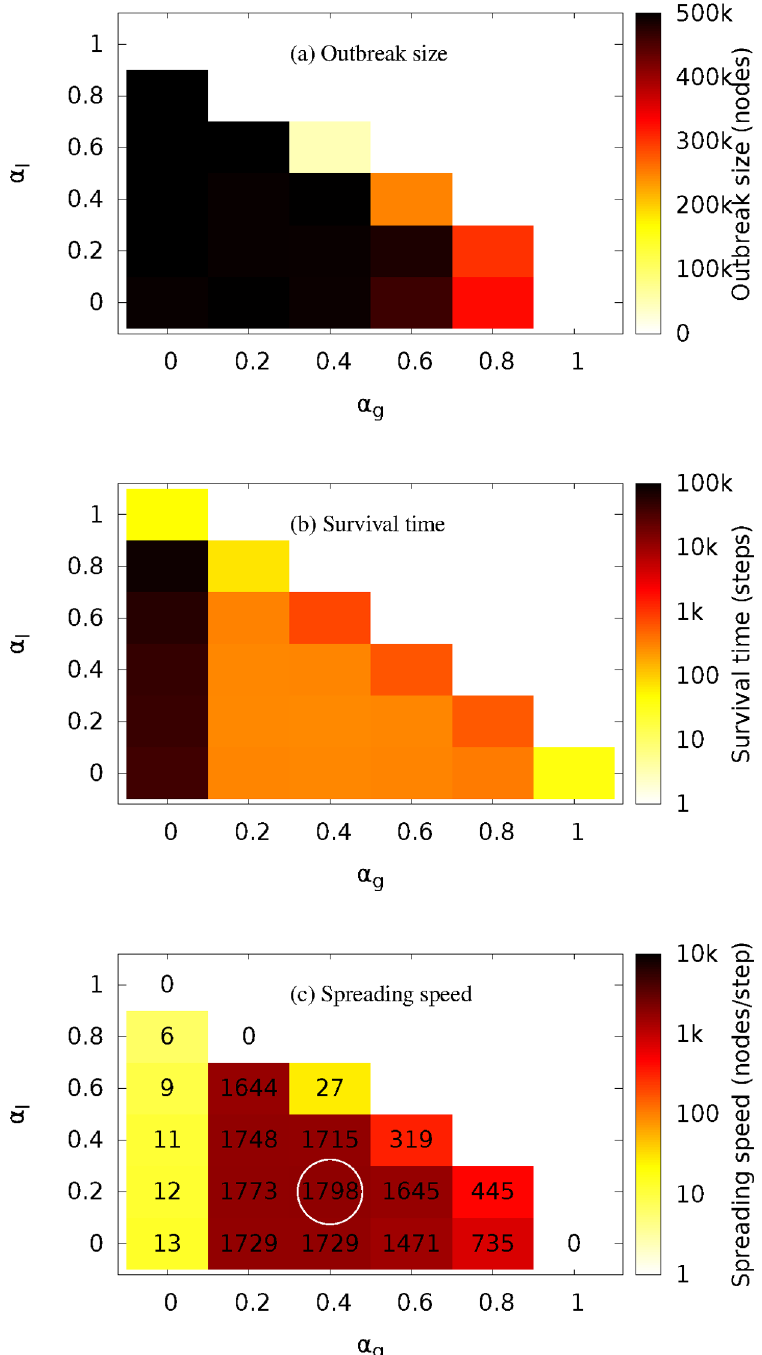
Fig 7. Simulation results when three of Conficker ’ s spreading mechanisms are mixed at different probabilities. Spreading properties shown include the final outbreak size, the survival time and the spreading speed (see colour maps) as functions of the mixing probabilities of global spreading α g (x axis) and local spreading α l (y axis), where the mixing probability of neighbourhood spreading is α n = 1 − α g − α l